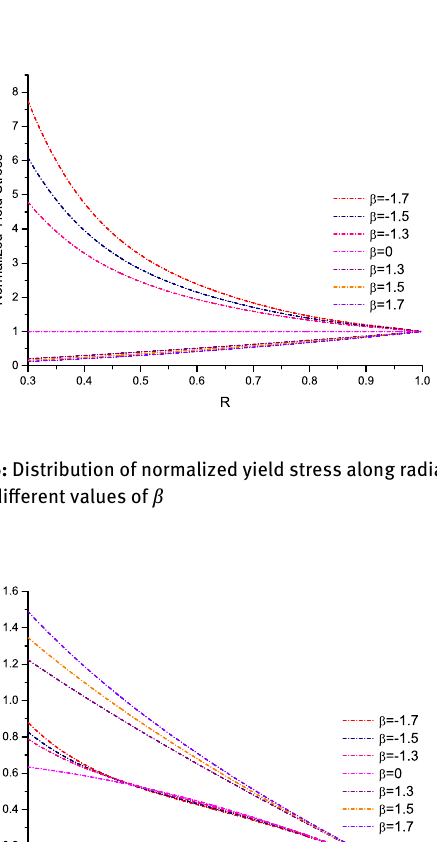
Figure 16: Distribution of normalized temperature along radial direc- tion for different values of β